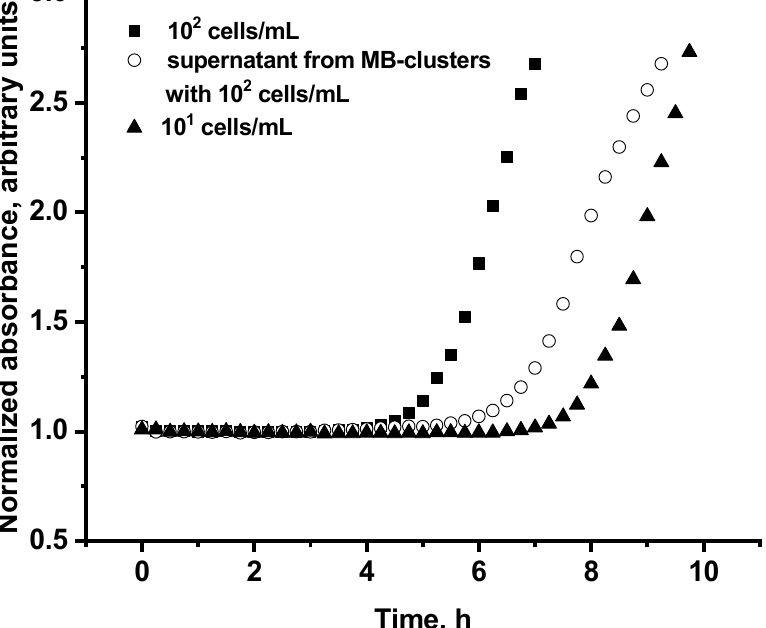
Figure 4. Cell growth profiles for E. coli cells assayed by recording the optical density of the samples (absorbance at λ = 620 nm). 10 2 E. coli cells/mL, supernatant after the IMS of E. coli cells at a concentration of 10 2 and diluted by ½ in the nutrient medium, 10 1 E. coli cells/mL. Data referenced at the first value.